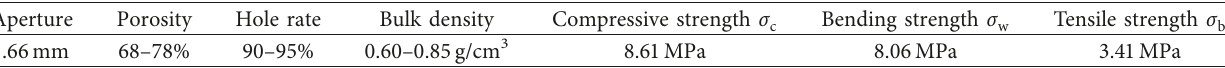
Figure 1: Preparation of the polyurethane-foamed aluminum. Table 1: Parameters of the open-cell aluminum foam.